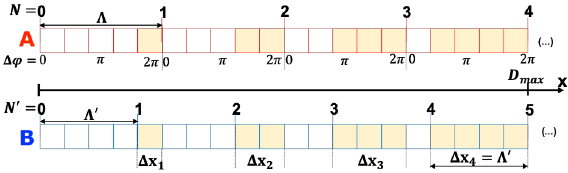
Figure 1. Comparison of two di ↵ erent rulers A and B. In A the distance between marks is determined by f and in B by f 0 = f +  f